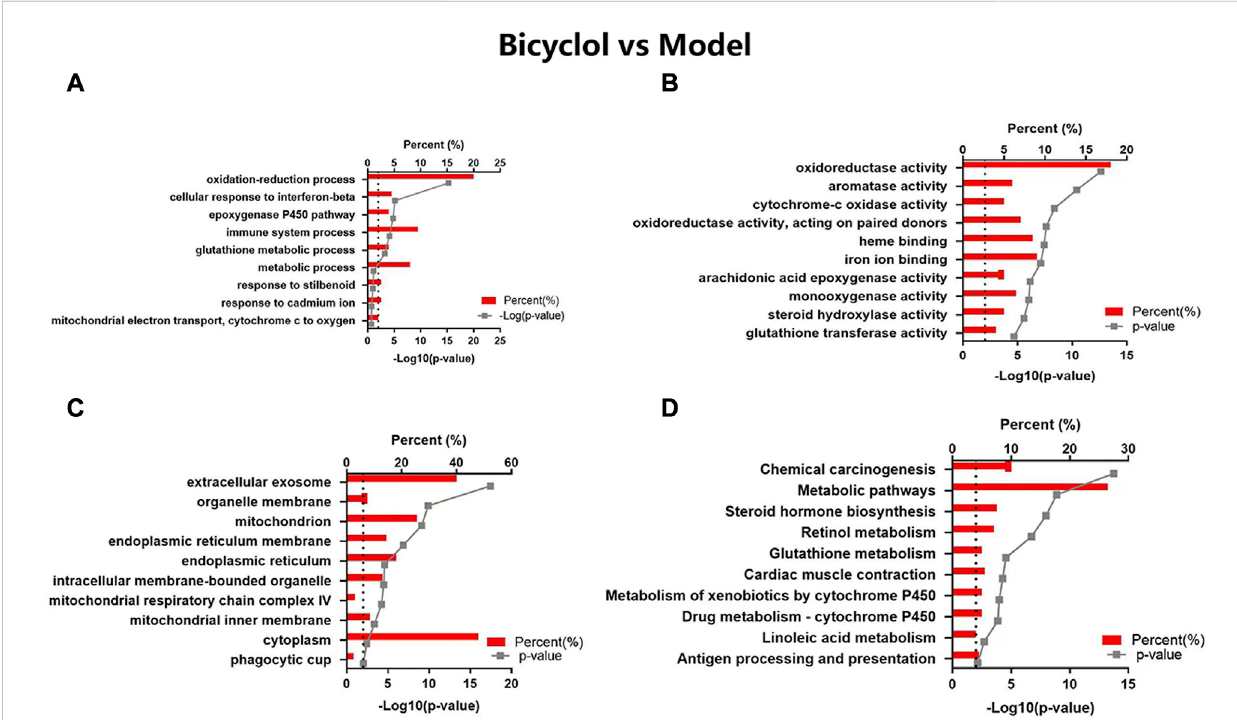
GOandKEGGpathwayanalysesofthechangedproteinsinBicyclolvsModelgroups.Theenricheditemsarelistedaccordingtothe p -value. (A) GO-BP, (B) GO-MF, (C) GO-CC, (D) KEGG pathway